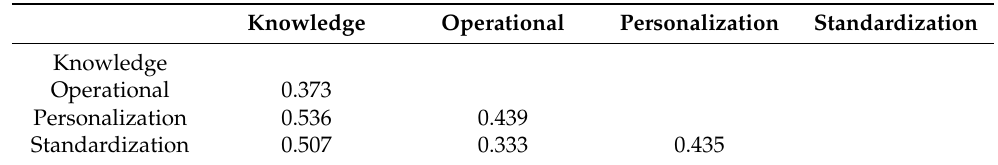
Table 8. Correlation of latent variables.